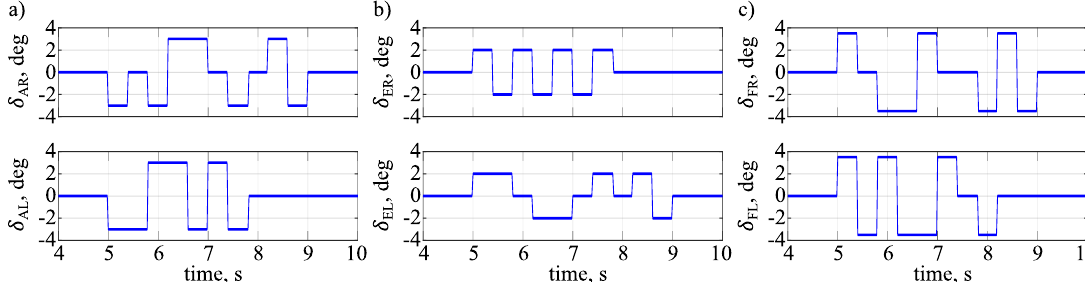
Figure 5. Multi-step exciattions for: ( a ) ailerons, ( b ) elevator parts, ( c ) flaps.